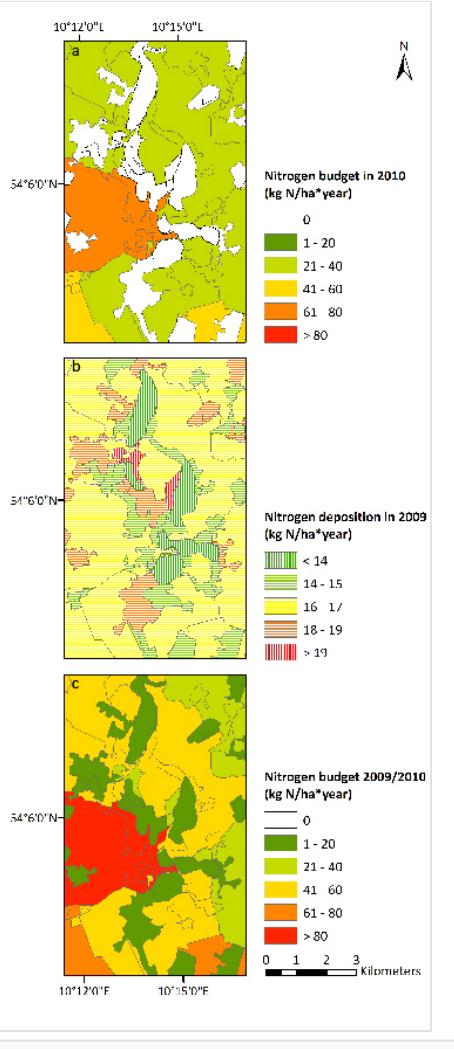
Figure 9. Nitrogen budgets in the Bornhöved Lakes District: (a) nitrogen budget 2010 (excl. nitrogen deposition) for each municipality allocated to arable land, (b) atmospheric nitrogen